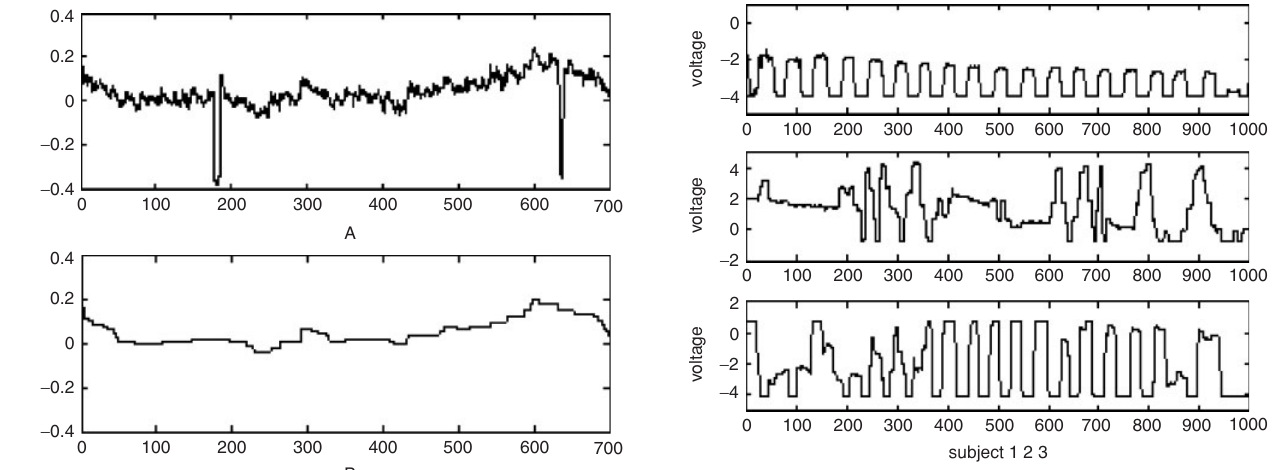
Figure 21 Using the median filter to remove the eye blink. Usingthemedianfiltertoremovetheeyeblinkfromthe corruptedsignal